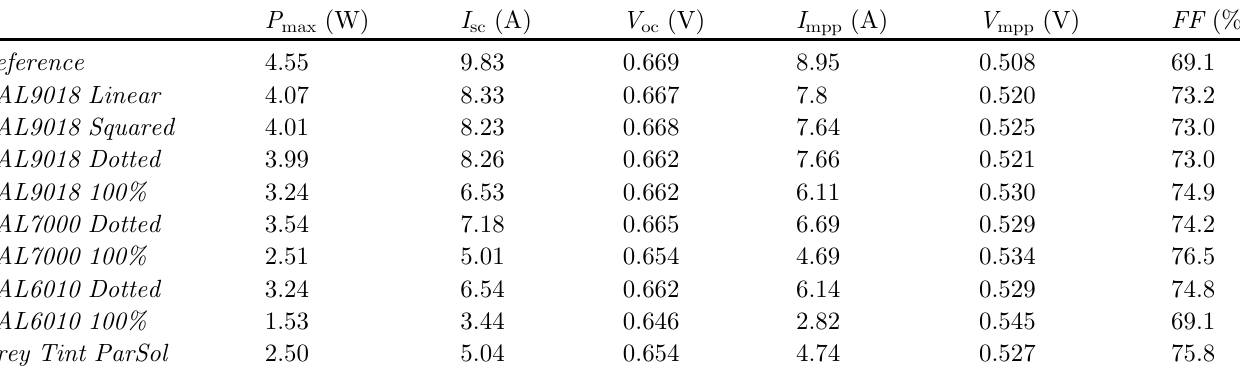
Table 2. Electrical parameters for 10 PV laminates with different color/pattern coatings after IV characterization at 600 W/m 2